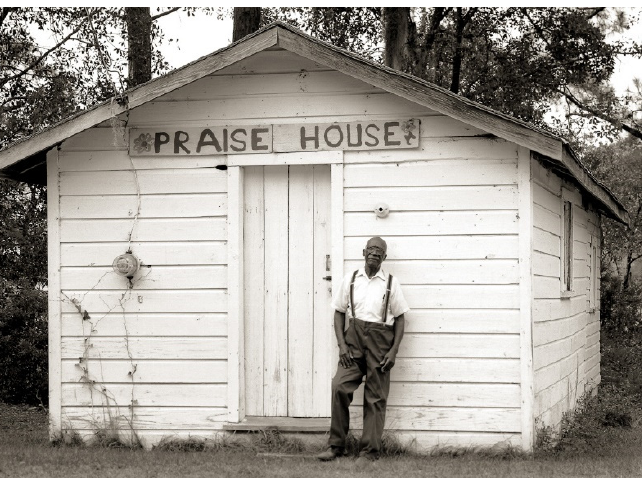
Figure 1. Image of a Gullah praise house, Saint Helena Island, South Carolina 1995. Image from the National Humanities Center at http://nationalhumanitiescenter.org (accessed on15 June 2018). National Humanities Center at http://nationalhumanitiescenter.org (accessed on 15 June